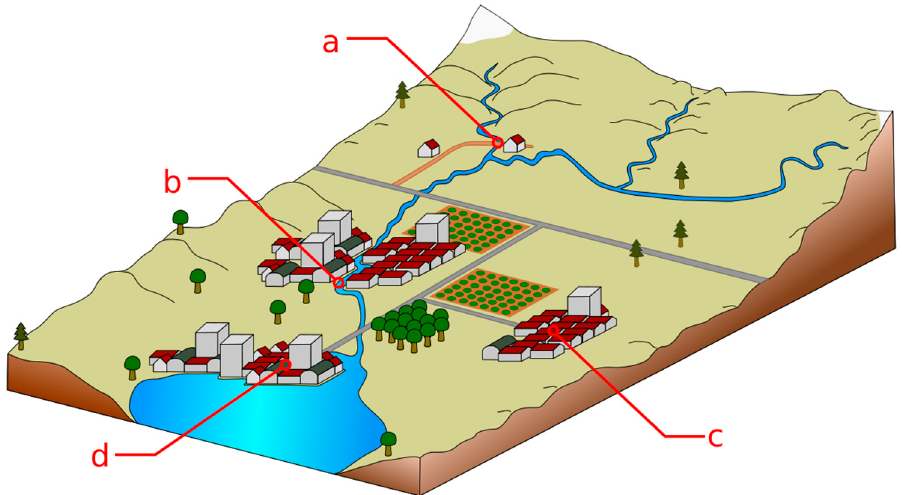
Figure 1. Different types of flash flood-prone environments include ( a ) non-urban steep catchments and ( b ) urban neighborhoods served or ( c ) not by a central drainage channel, and ( d ) coastal urban zones.